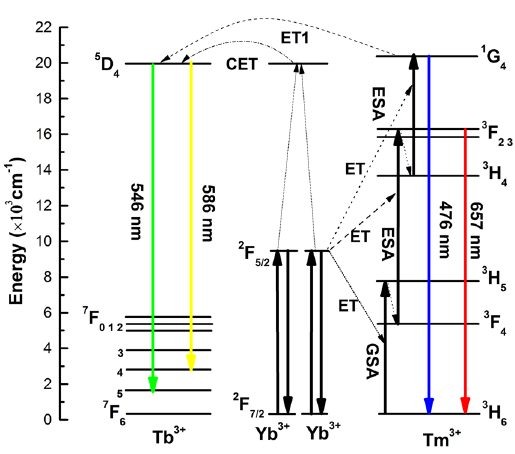
Figure 8. Mechanism for UEC and energy transfer processes of Tm 3 + /Tb 3 + /Yb 3 + co-doped in the SAB glass- ceramics under 980 nm